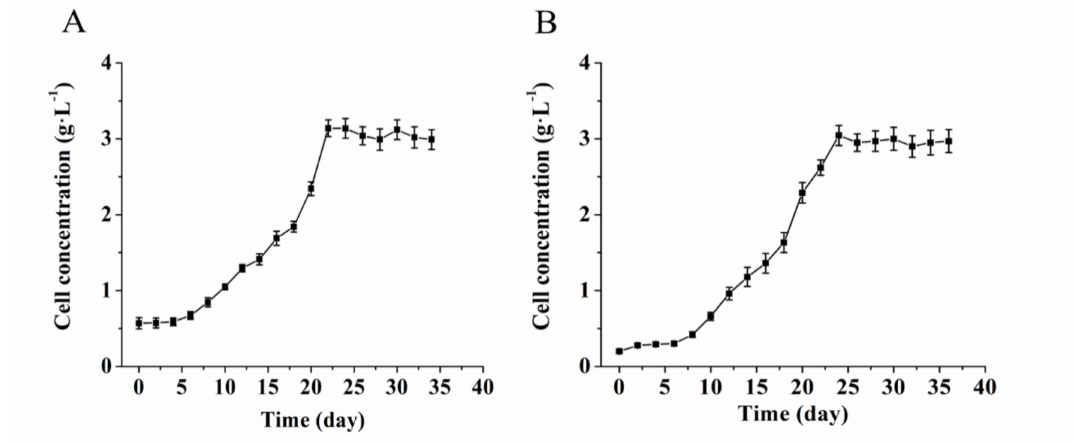
Figure 1. The growth curve of N. oceanica IMET1 ( A . fresh seawater BG-11; B . electro-Fenton resulting